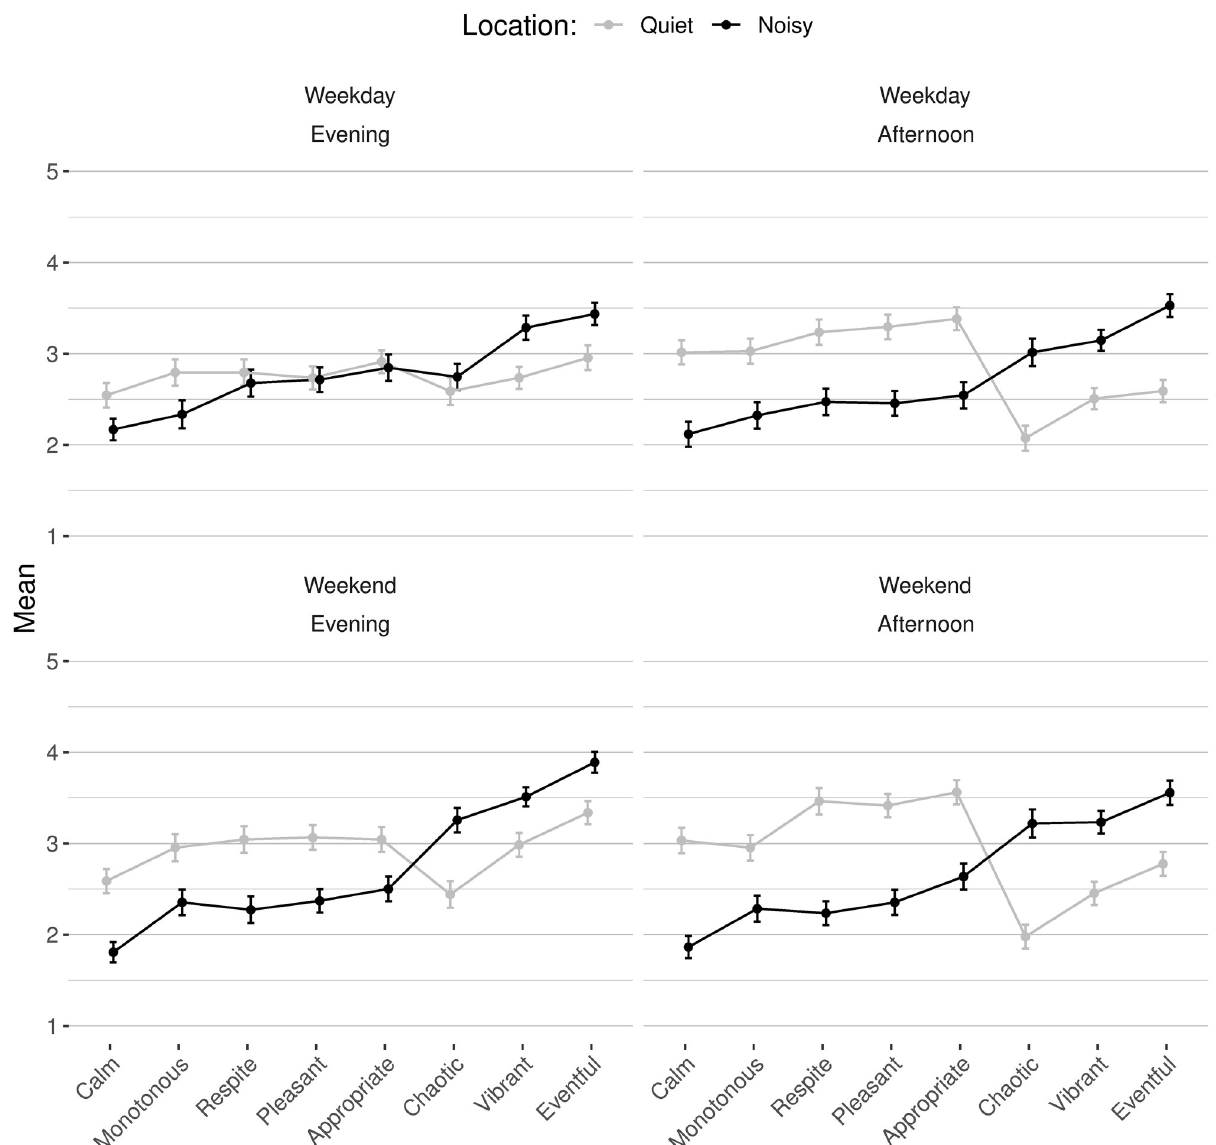
Fig 4. Means and SE of all scales as a function of day, time, and location for the laboratory data (N =